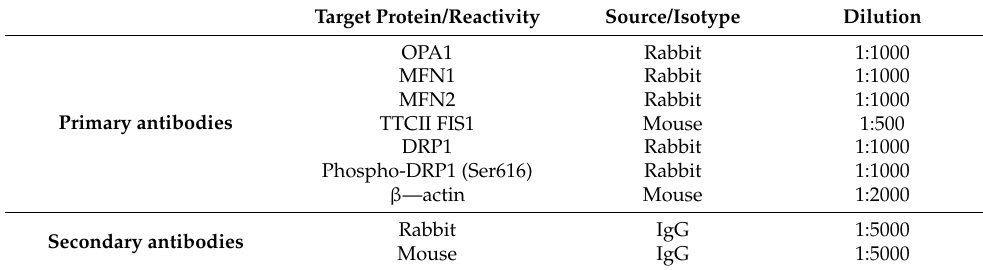
Table 1. Antibodies and dilutions used for mitochondrial dynamics proteins